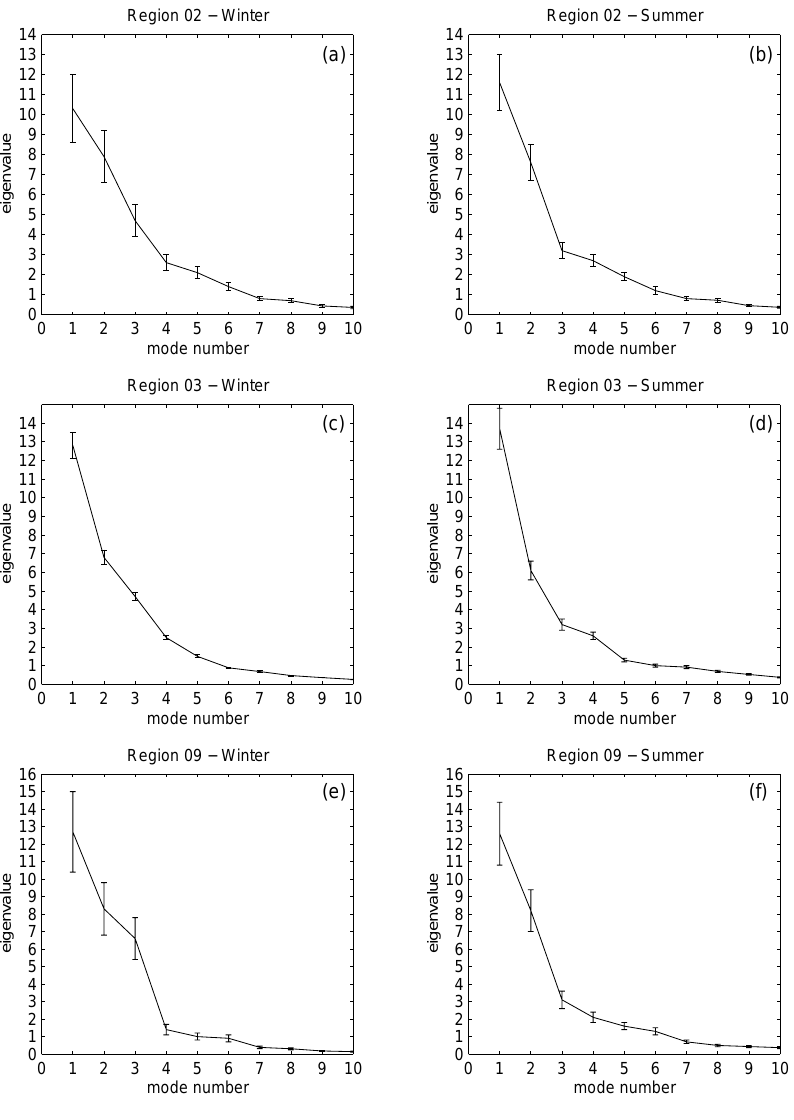
Fig. 12. Diagram of the first ten eigen- values ( λ k ) of the insitu EOFs ver- sus the mode number k in winter (a) and summer (b) for the Algerian Basin, winter (c) and summer (d) for the north- western Basin, and winter (e) and sum- mer (f) in the Levantine Basin. The er- ror bars represent the sampling errors ( δλ k